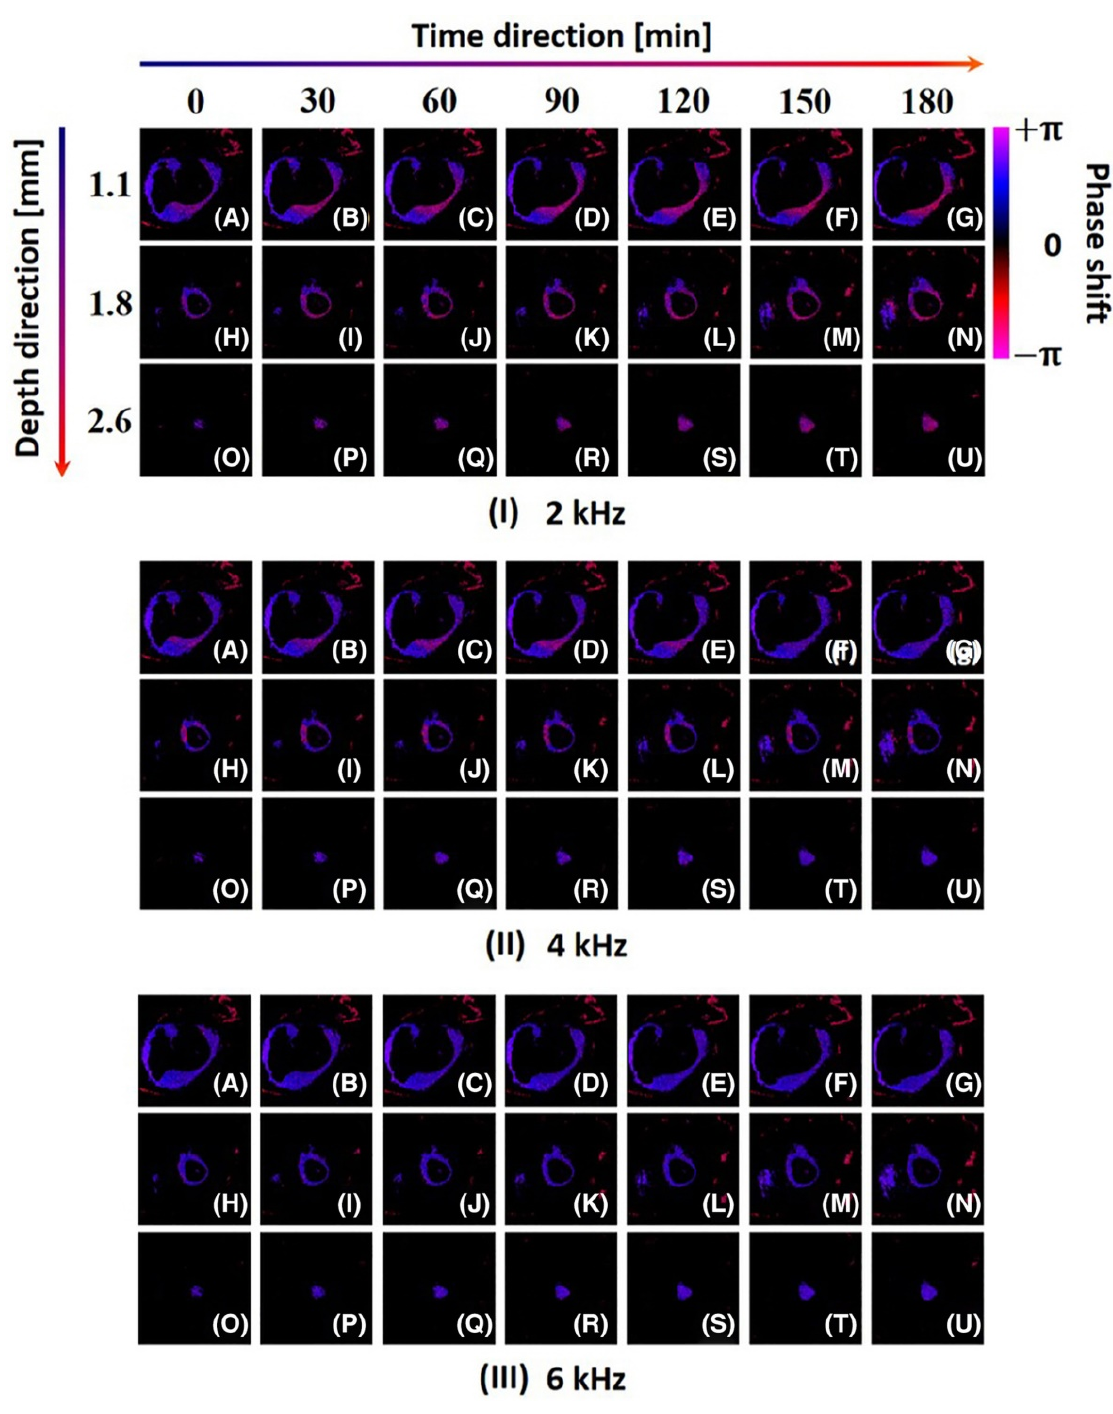
Figure 5. Depth-dependent enface ODV representation of TM for multiple experimental trials. I ( A – G ): enface ODV images at 2 kHz frequency and 1.1 mm depth. I ( H – N ): enface ODV images at 2 kHz frequency and 1.8 mm depth. I ( O – U ): enface ODV images at 2 kHz frequency and 2.6 mm depth. II ( A – G ): enface ODV images at 4 kHz frequency and 1.1 mm depth. II ( H – N ): enface ODV images at 4 kHz frequency and 1.8 mm depth. II ( O – U ): enface ODV images at 4 kHz frequency and 2.6 mm depth. III ( A – G ): enface ODV images at 6 kHz frequency and 1.1 mm depth. III ( H – N ): enface ODV images at 6